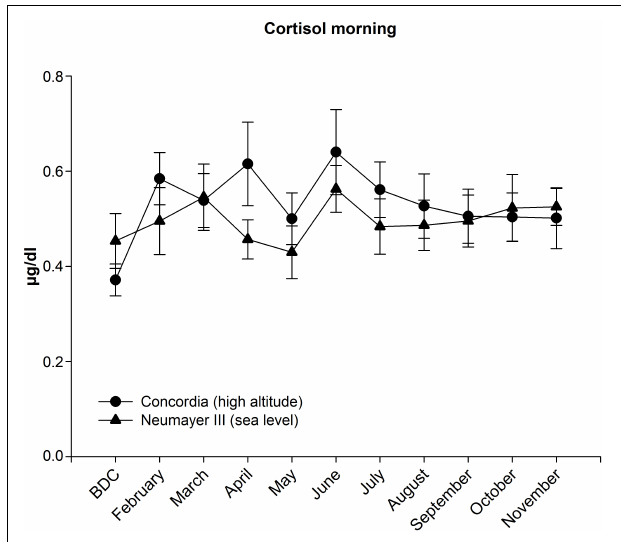
FIGURE 3 | Cortisol in saliva in the morning at Neumayer III (sea level) ( n = 13–16) and Concordia (high altitude) ( n = 12–15); data are means ± SEM; units are µ g/dl; BDC, baseline data